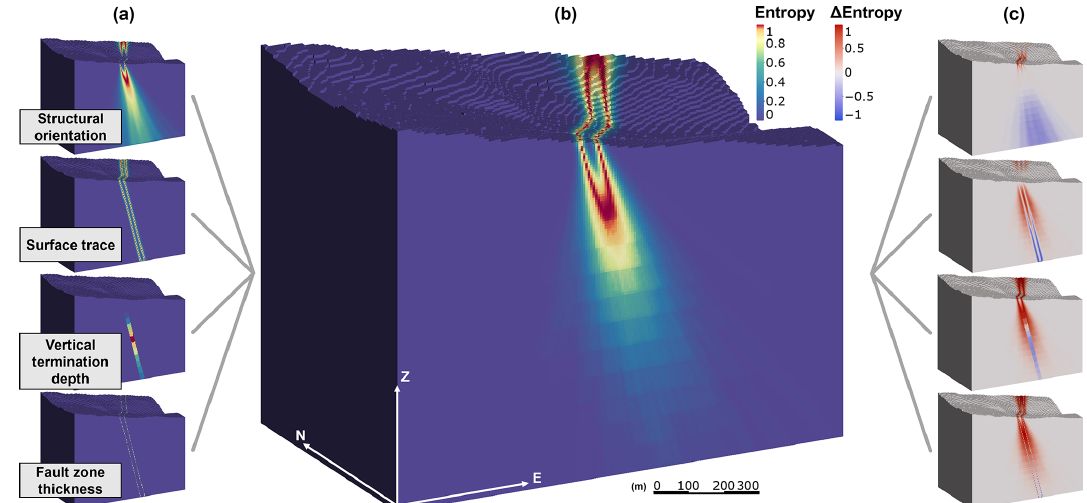
Figure 5. Block models showing information entropy quantified from (a) independent modeling inputs and (b) combined modeling inputs. The difference between the combined geologic model uncertainty and each independent modeling input is shown in (c) , where blue values indicate that the independent modeling input showed greater entropy than the combined model